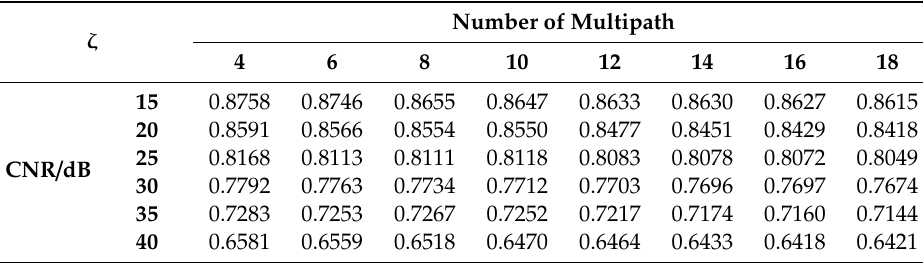
Table 2. Similarity coe ffi cient in di ff erent